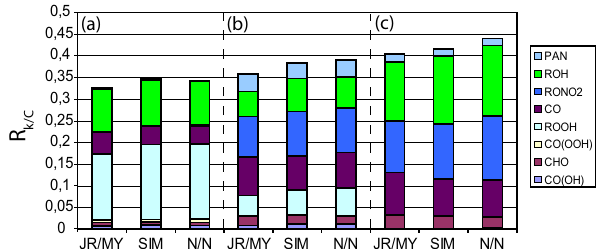
Fig. 8. Simulated distribution of condensed secondary organics as a function of carbon and function at the end of the (a) low-, (b) intermediate- and (c) high-NO x experiments. C10Fi stands for species having 10 carbon atoms and bearing i functional groups. Percentages are computed on a per carbon atom basis.